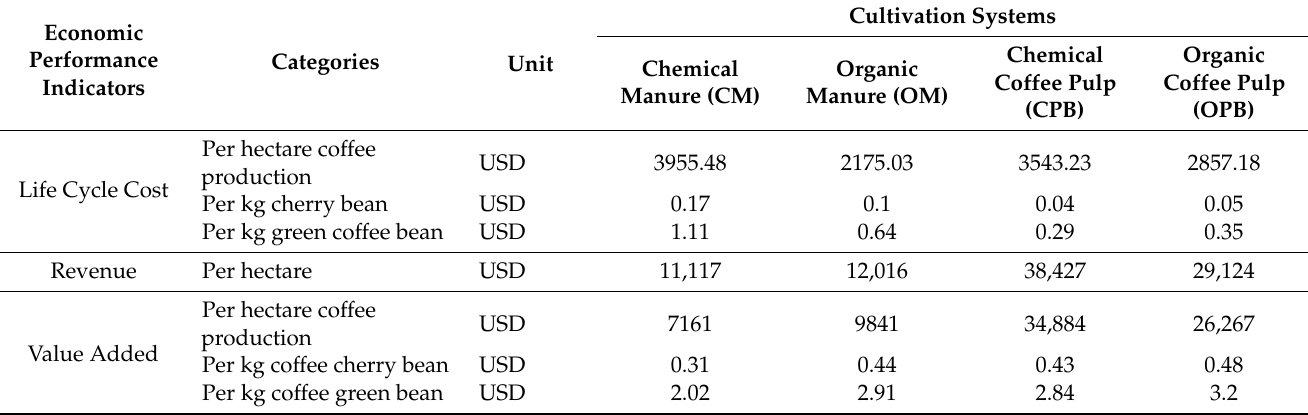
Table 4. The environmental performance of coffee production in the cultivation